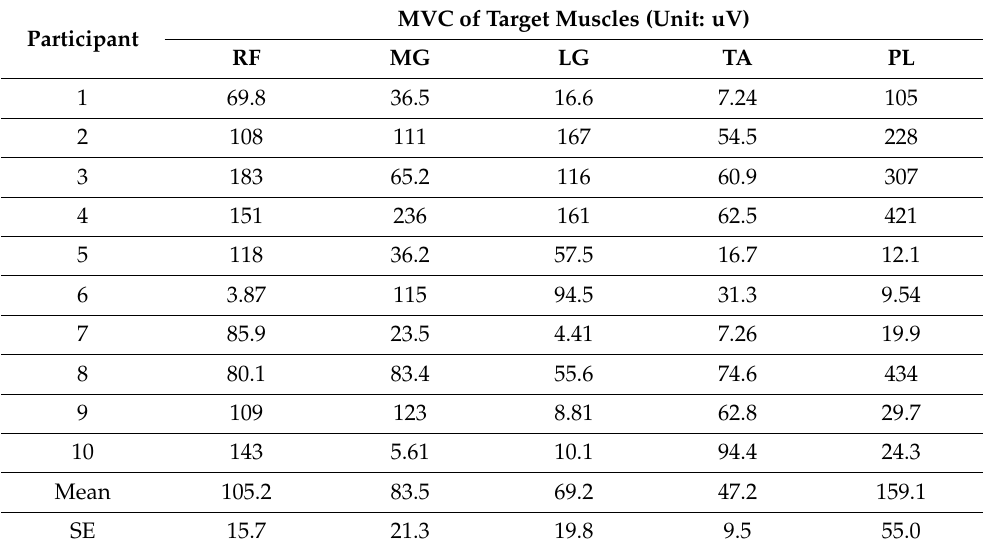
Table 1. The MVC of the five target muscles (RF: rectus femoris, MG: medial gastrocnemius, LG: lateral gastrocnemius, TA: tibialis anterior, PL: peroneus longus, n = 10).